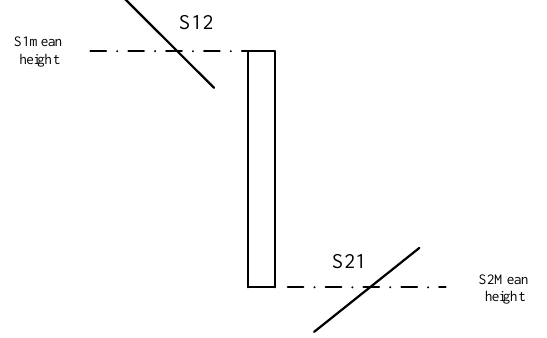
Table 2. different cases in filtering